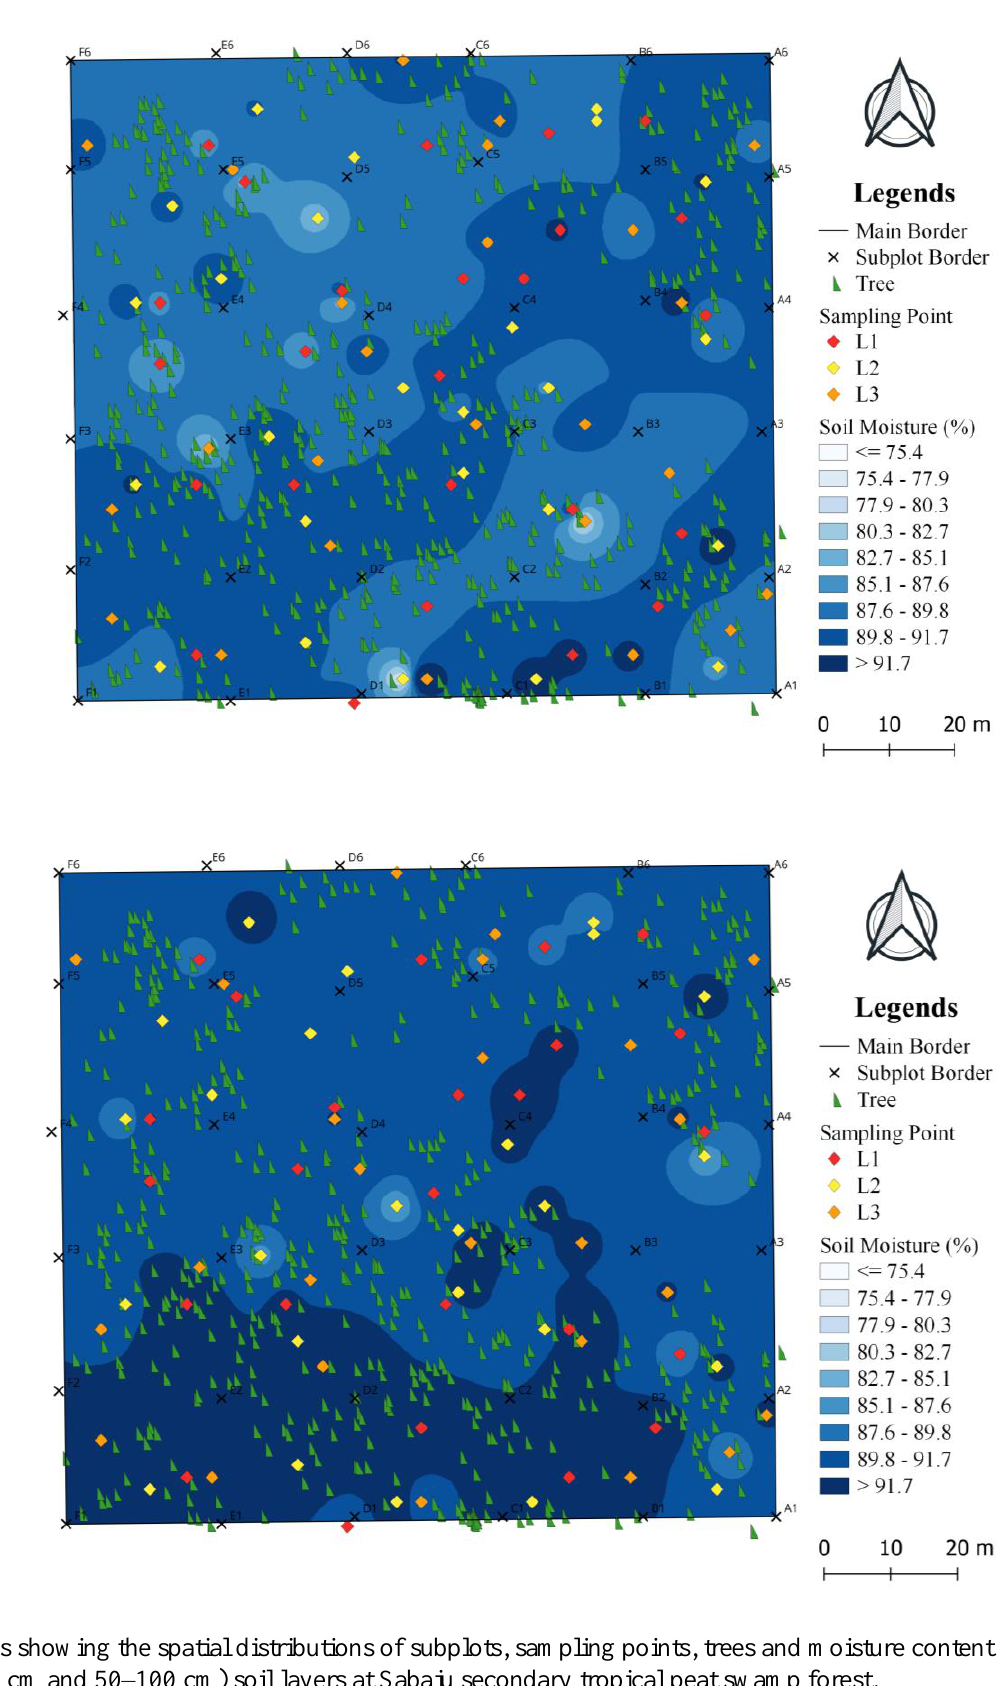
Figure 6. Maps showing the spatial distributions of subplots, sampling points, trees and moisture content in shallow (0–50 cm and 50–100 cm) soil layers at Sabaju secondary tropical peat swamp